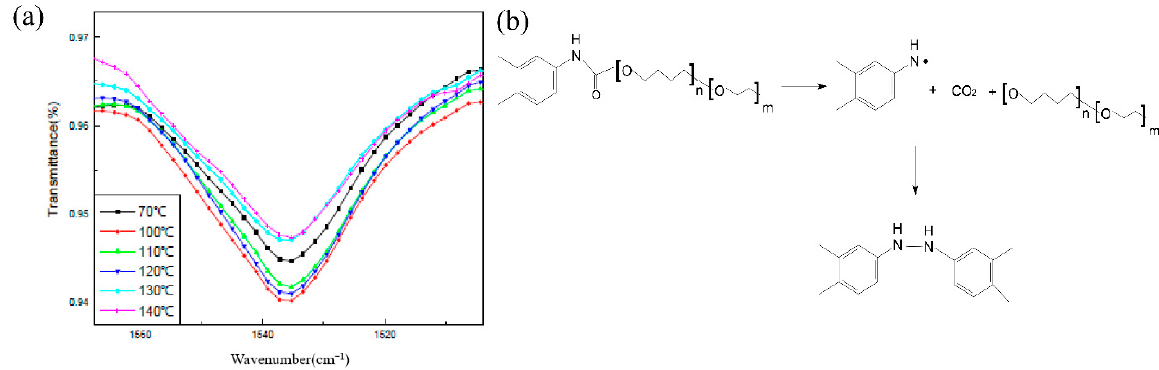
Figure 11. The infrared spectrum of HTPE film at room temperature.